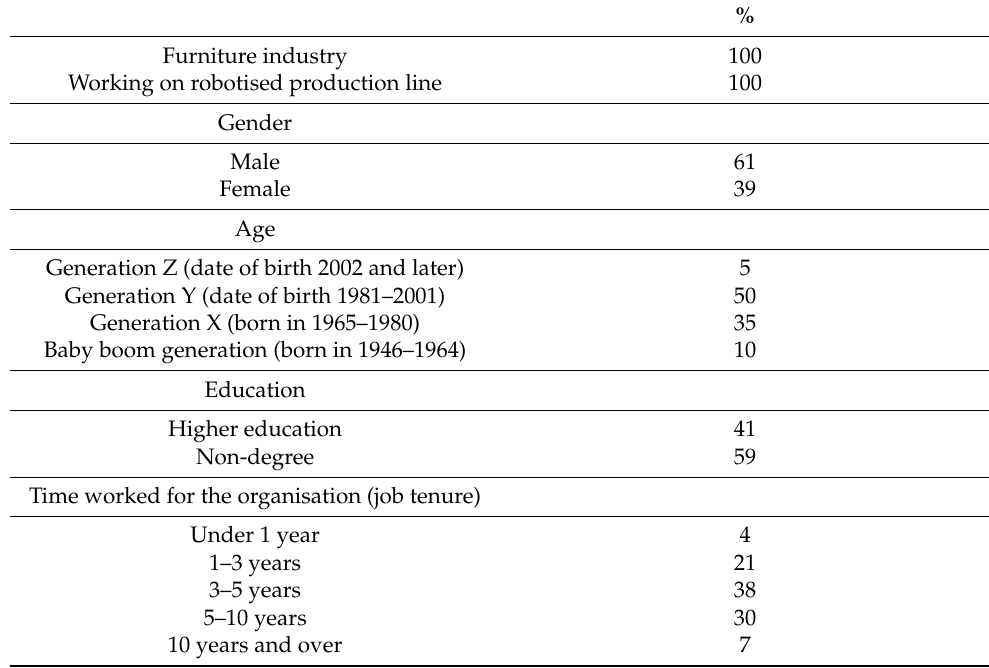
Table 2. Respondents’